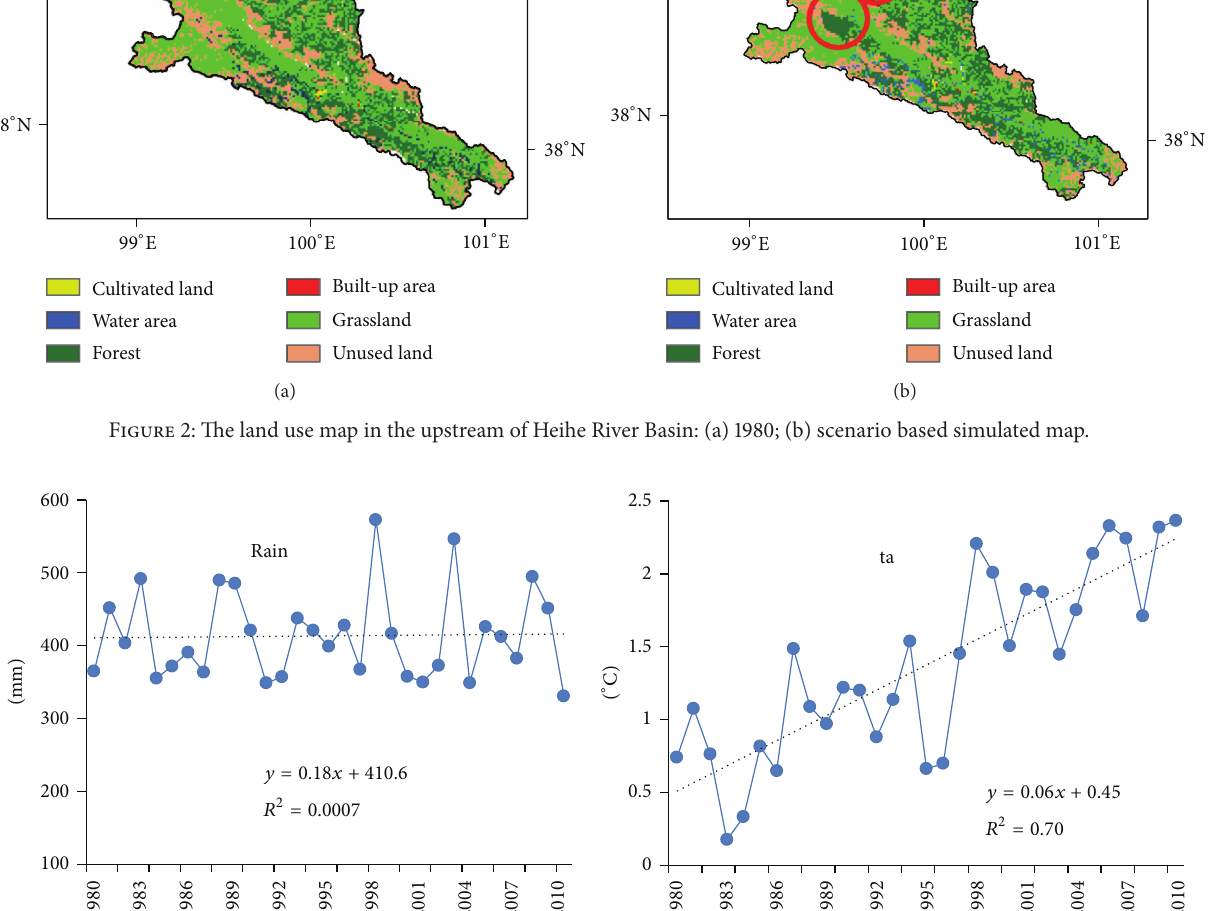
where SW 𝑡 is the final soil water content (mm H 2 O), SW 0 is the initial soil water content on day 𝑖 (mm H 2 O), 𝑡 is the is the amount of precipitation on day 𝑖 time (days), 𝑅 day is the amount of surface runoff on day 𝑖 (mm H 2 O), 𝑄 surf is the amount of evapotranspiration on day 𝑖 (mm H 2 O), 𝐸 sub is the amount of water entering the vadose (mm H 2 O), 𝑤 seep zone from the soil profile on day 𝑖 (mm H 2 O), and 𝑄 amount of return flow on day 𝑖 (mm H 2